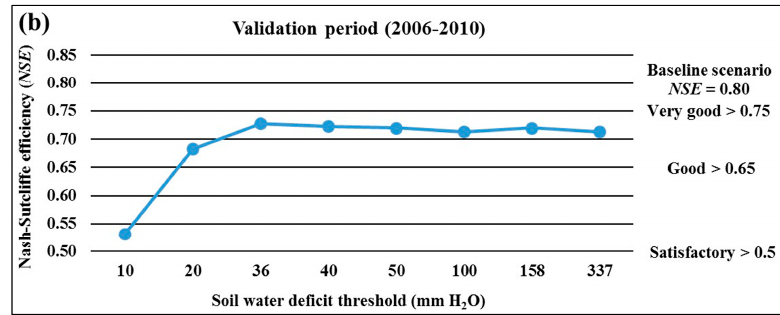
Figure 5. Model performance statistic of NSE for daily measured and simulated ET during ( a ) calibration (2001–2005) and ( b ) validation (2006–2010) periods under different soil water deficit thresholds using SWAT auto-irrigation functions.